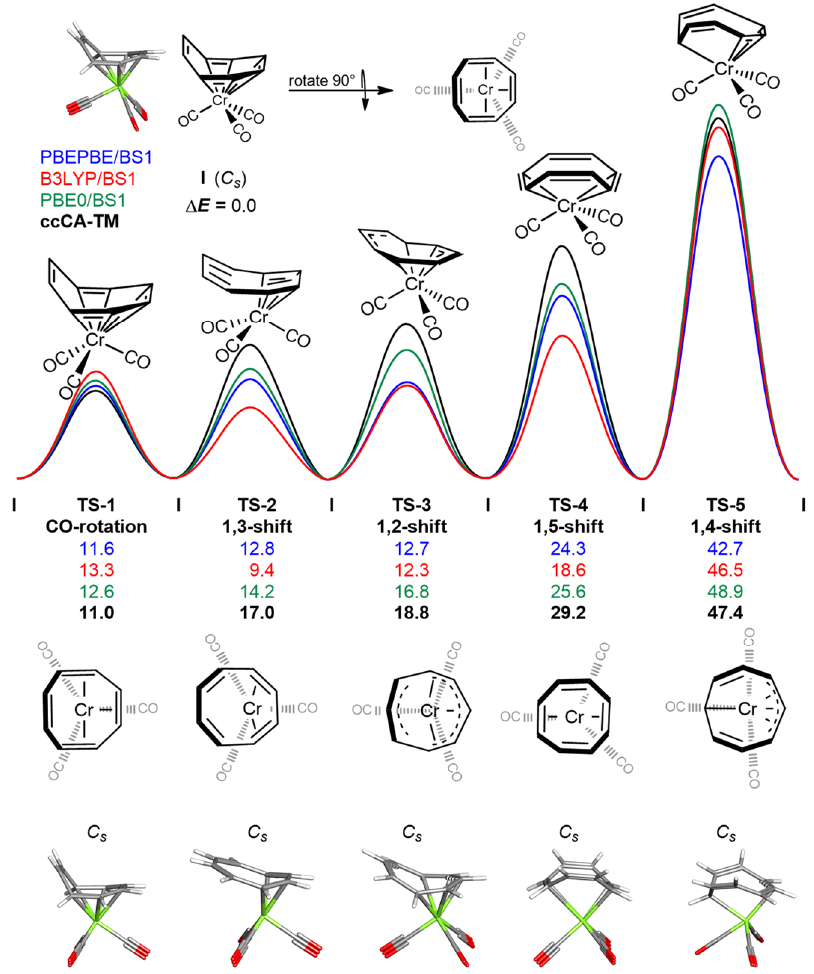
Figure 2. Potential energy surface for the ring rearrangement processes of (COT)Cr(CO) 3 at various levels of theory. Relative electronic energies (Δ E e ‡ ) are given in kcal mol −1 . Transition states are ordered in reference to Δ E e ‡ values derived from ccCA-TM.